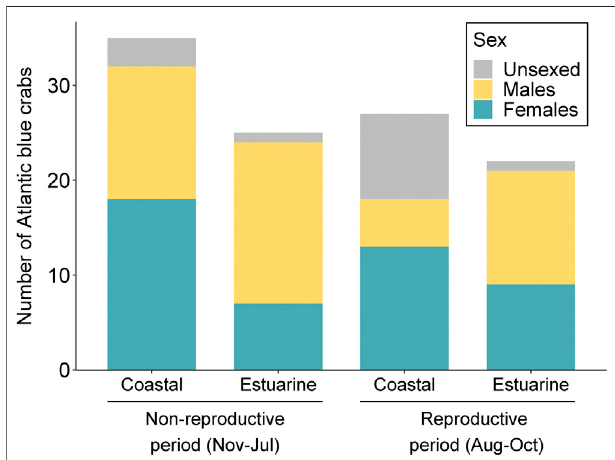
FIGURE 6 | Records of Atlantic blue crabs made in coastal or estuarine ecosystems of Algarve, according to the reproductive or non-reproductive period and their sex, submitted to NEMA by citizen scientists between April 2019 and the end of March 2020.